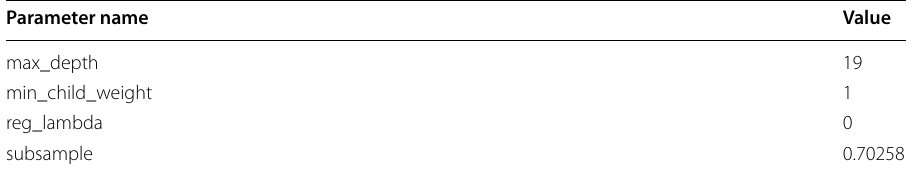
Table 61 Modes of XGBoost tuned hyperparameter values for experiments with the information theft dataset